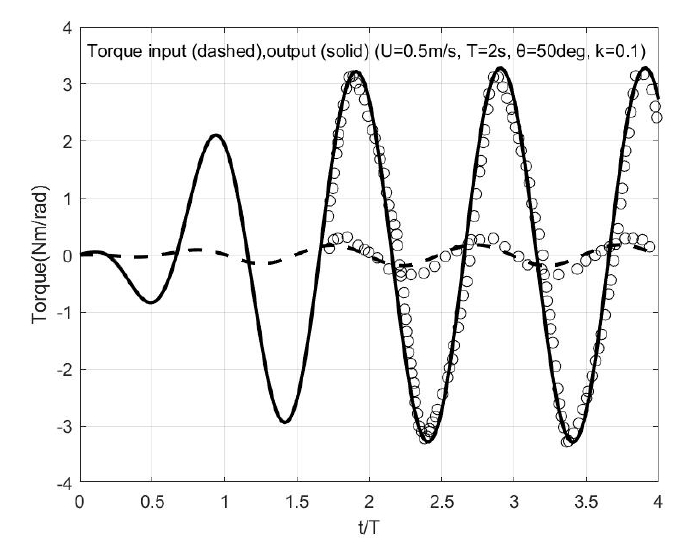
Figure 6. Input and output torque as a function time as calculated by the present model for the considered system for the same case as in Figure 4. Input torque is shown by using dashed lines and output torque by solid lines, respectively. Experimental data from [7] are indicated by using symbols.